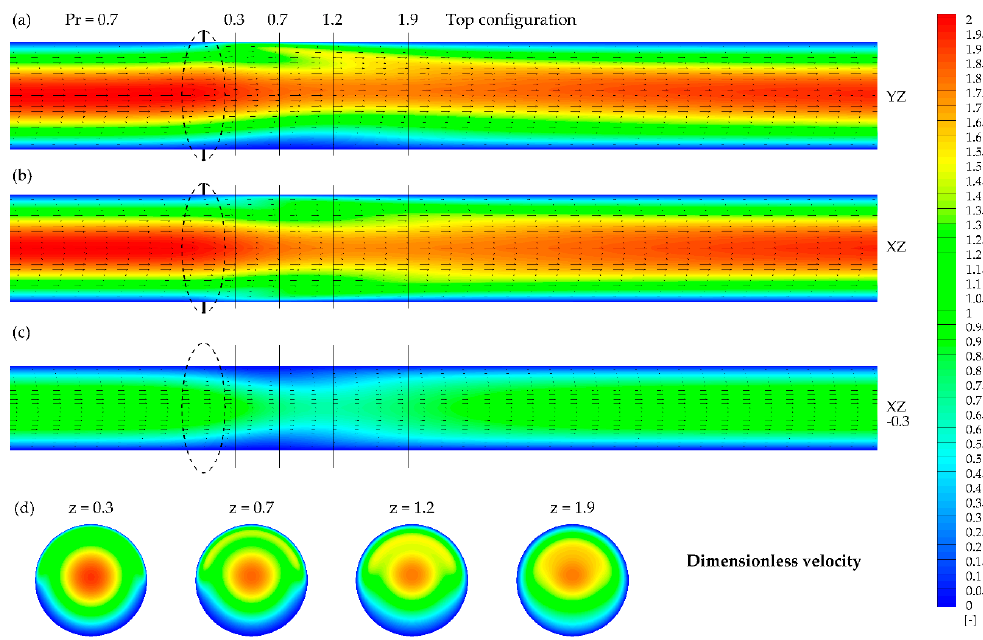
Figure 6. Dimensionless velocity contours and vectors obtained for Pr = 0.7 and top configuration in the presence of the magnetic field at: ( a ) YZ plane, ( b ) XZ plane, ( c ) XZ plane ( y = − 0.3), ( d ) XY planes at given z .